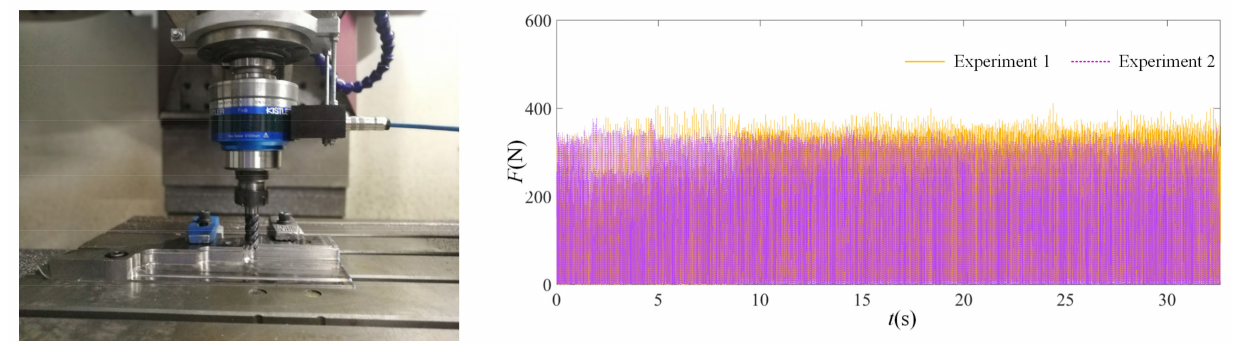
Figure 13. Installation of cutting force measurement device and measured main cutting force in experiments.